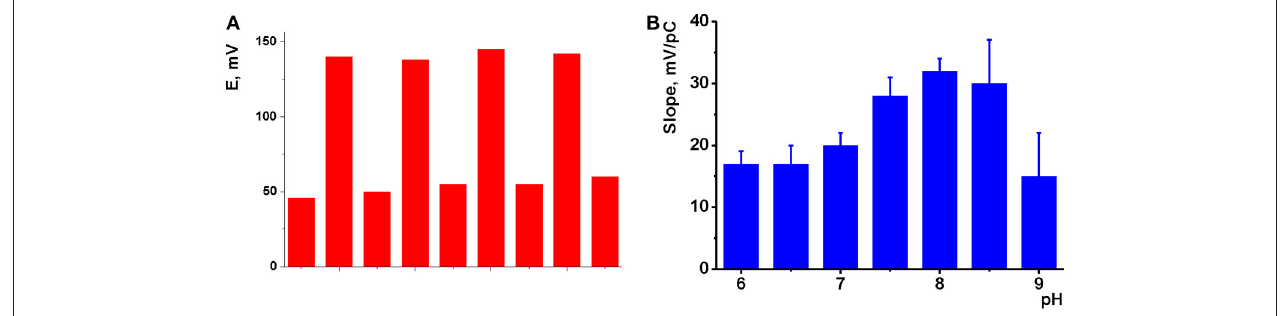
FIGURE 4 | (A) Reversibility of the response of potentiometric to 10.0mM and 10.0 µ M Na 2 HPO 4 , pH 8.0, intermediate washing in deionized water and short heating to 80 ◦ C; (B) pH dependence of the slope of linear part of hydrogen phosphate calibration curve (mean ± S.D. for three replications). Potentiometric sensor based on sensor based on CB and IL 1 .